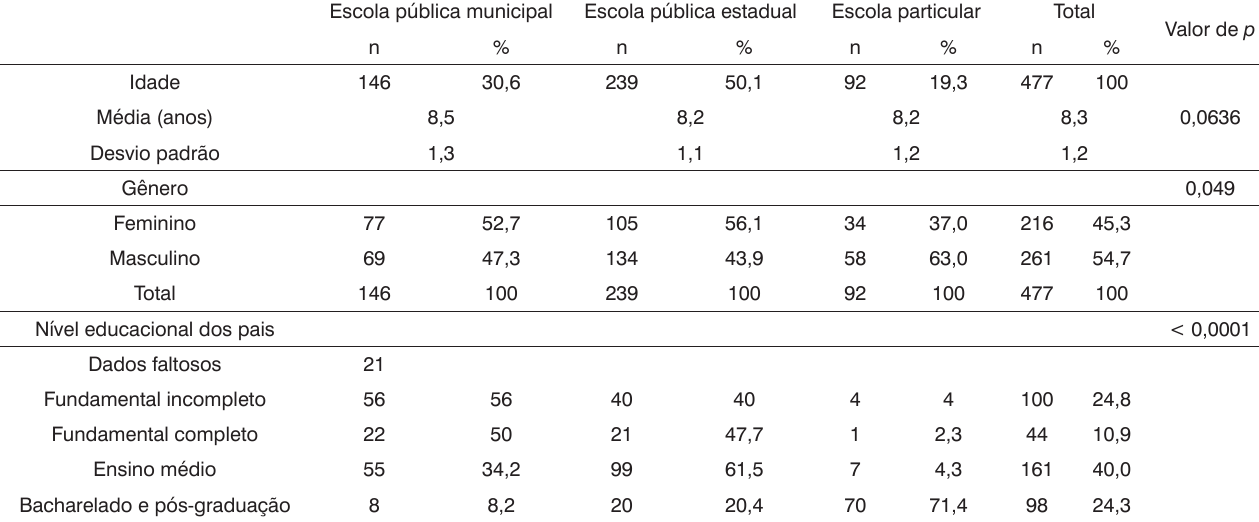
Tabela 1. Idade, gênero e nível educacional dos pais em relação às escolas, sendo públicas ou